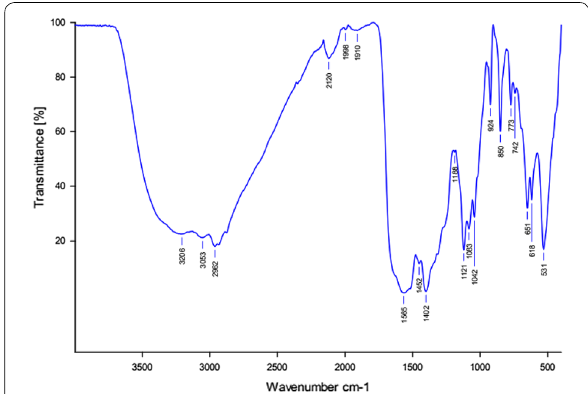
Fig. 2 FTIR spectrum of biosurfactants produced by the strain L. paracasei subsp. tolerans N2 with molasses as carbon